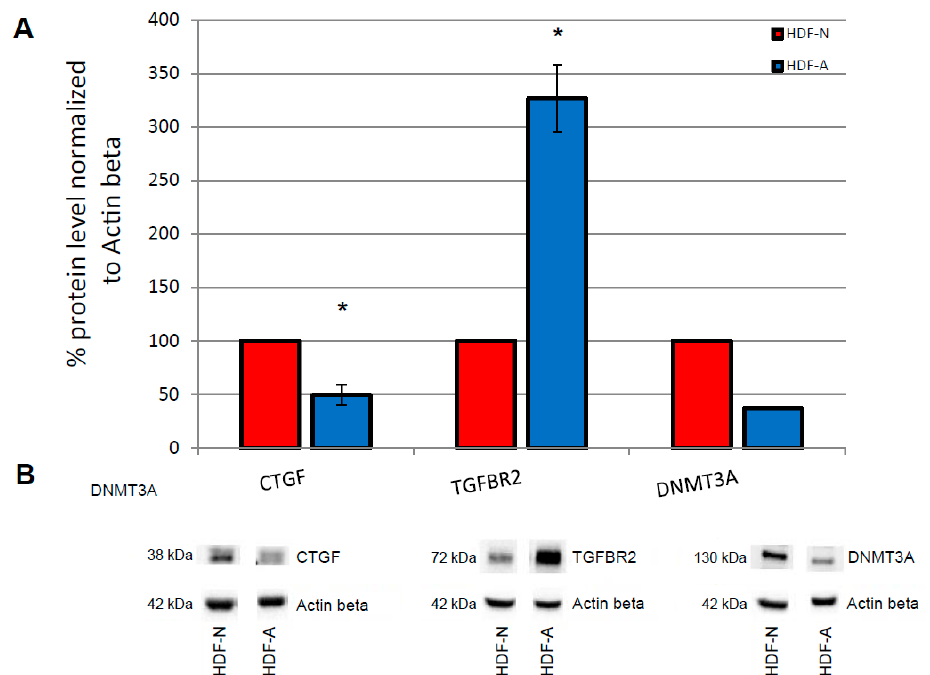
Figure 2. The endogenous in vitro level of CTGF, TGFBR2 and DNMT3A proteins in neonatal (HDF ‐ N) and adult (HDF ‐ A) human dermal fibroblasts. ( A ) The endogenous protein level for all analyzed proteins was normalized to Actin β . The protein level in HDF ‐ N cells was considered as 100%. En ‐ dogenous CTGF protein level is significantly lower in HDF ‐ A cells compared to HDF ‐ N, contrary to endogenous TGFBR2 protein level which is significantly higher in HDF ‐ A compared to HDF ‐ N cells (* p ‐ value < 0.05). Error bars represent standard error of the mean. All but one (DNMT3A) experiment was performed in triplicate. ( B ) The immunoblots show differences in endogenous pro ‐ tein levels between analysed cell lines.